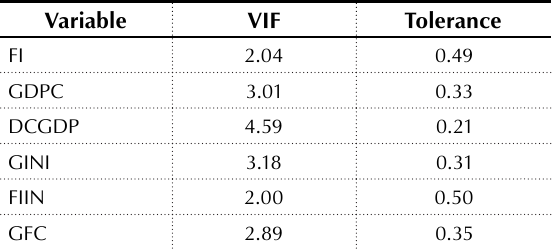
Table 3. Results of multicollinearity test